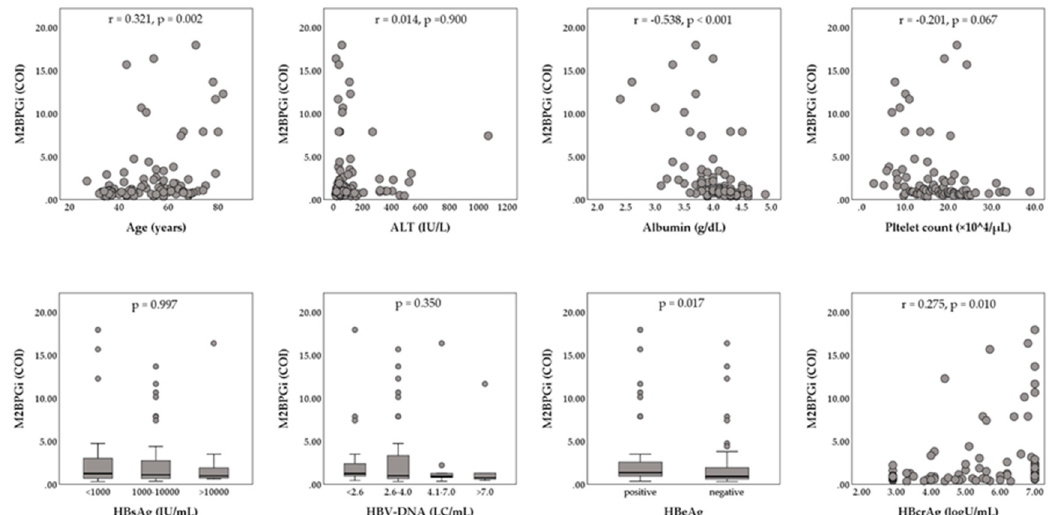
Figure 1. Relationships between Serum levels of Mac-2-binding protein glycosylation isomer (M2BPGi) and patients’ characteristics at baseline. The Mann–Whitney U-test or Kruskal–Wallis test was used for the categorical data. Spearman’s rank correlation coefficient was used for the continuous data. ALT, alanine aminotransferase; COI, cut-off index; HBcrAg, hepatitis B core-related antigen; HBeAg, hepatitis B e-antigen; HBsAg, hepatitis B surface antigen; HBV, hepatitis B virus; LC, log copies.